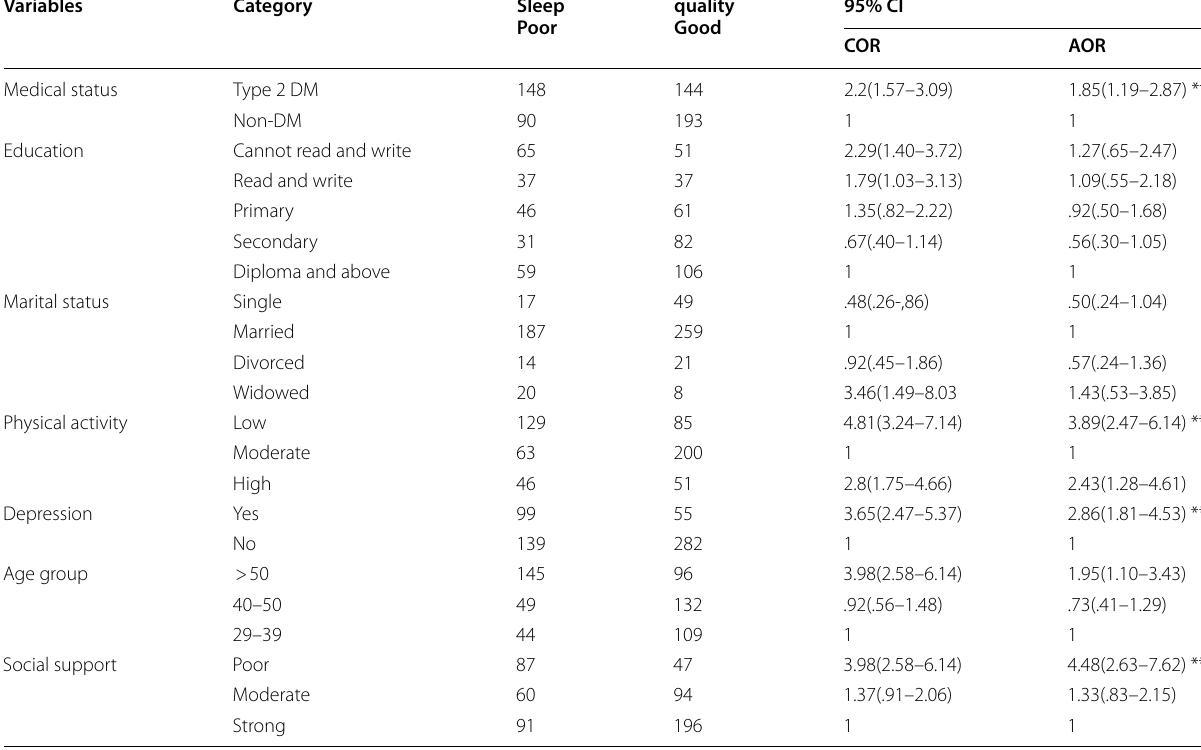
Table 6 Bi-variable and multivariable logistic regression analysis on sleep quality among type 2 DM and non-DM individuals (overall study participants) Bahir Dar city, Ethiopia